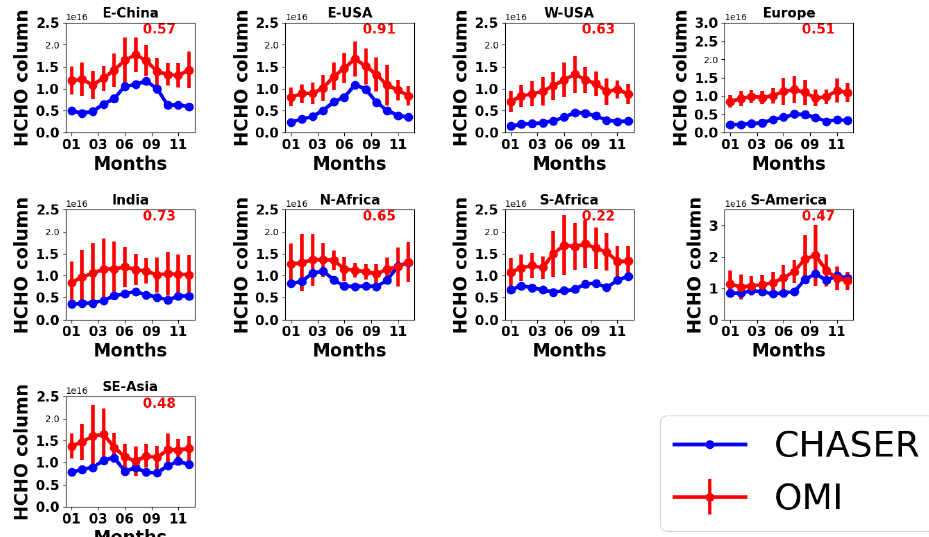
Figure 9. Seasonal variations in HCHO columns in E China (30–40 ◦ N, 110–123 ◦ E), E USA (32–43 ◦ N, 71–95 ◦ W), W USA (32–43 ◦ N,